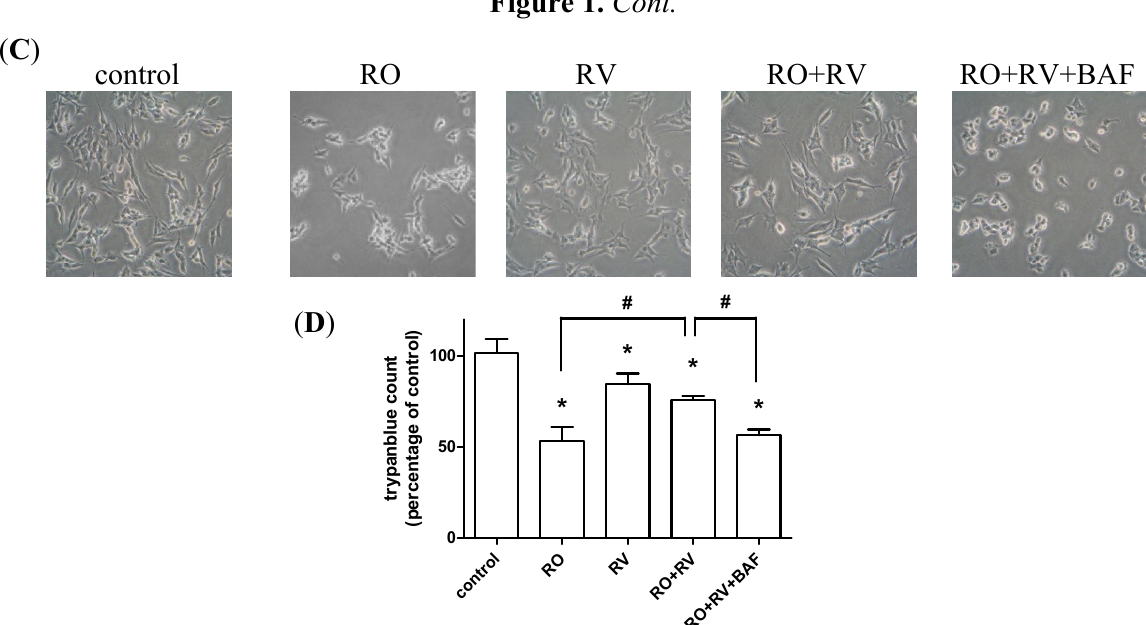
Figure 2. The protective effect of resveratrol against rotenone-induced neurotoxic apoptosis is associated with autophagy. SH-SY5Y cells pretreated with/without 20 μ M resveratrol for 24 h were treated with/without 20 μ M rotenone in the presence/absence of 10 nM bafilomycin A1 for the next 24 h. ( A , B ) Apoptotic cell death was detected by TUNEL immunofluorescence staining (green). Nuclei were stained with DAPI (blue). Scale bar, 50 μ m. Apoptotic cells were quantitated using Image J (NIH, USA) and data are presented as the percentage of TUNEL-positive cells to DAPI-positive cells; ( C , D